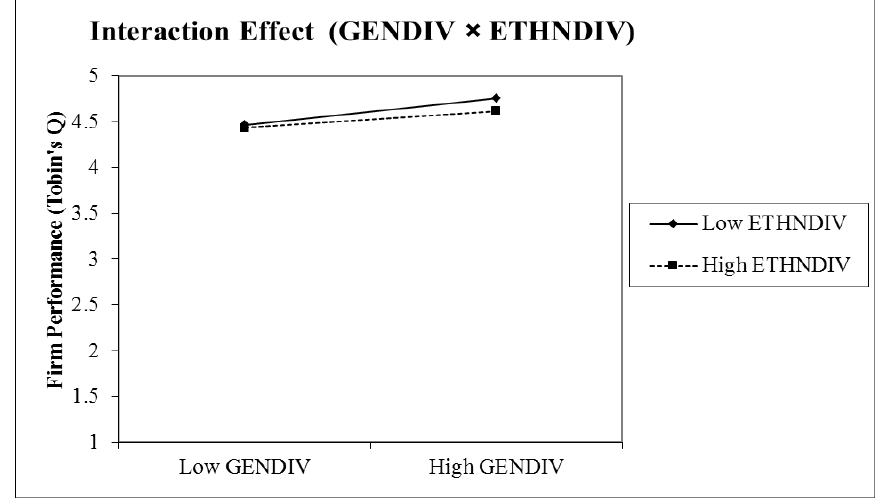
Figure 3. Interaction Effect (Gender Diversity × Ethnic Diversity).